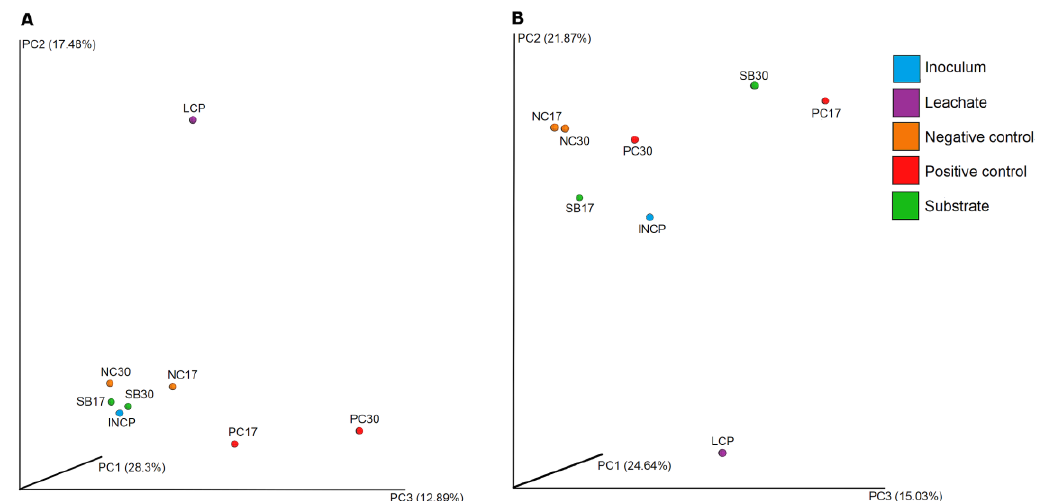
Figure 6. Beta-diversity of the bacteria ( A ) and archaea ( B ) in the leachate (LCP), inoculum (INCP), and treatment groups (NC, PC, and SB). Three different axes, PC1, PC2, and PC3, show the total percentage of dissimilarity.